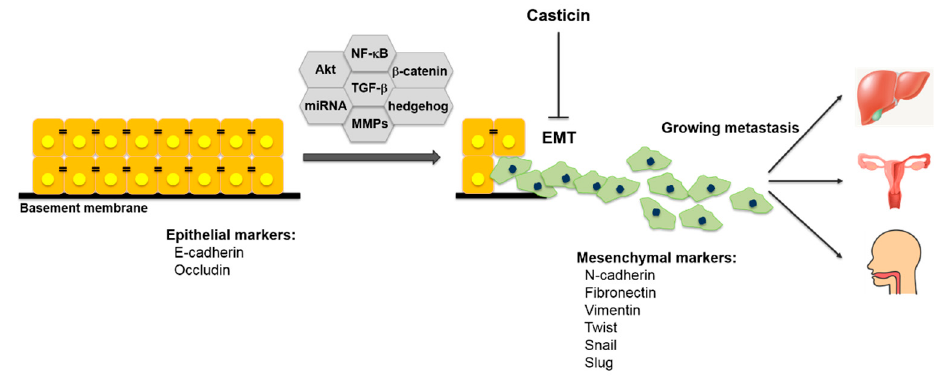
Figure 4. The role of casticin in regulating epithelial-mesenchymal transition (EMT).